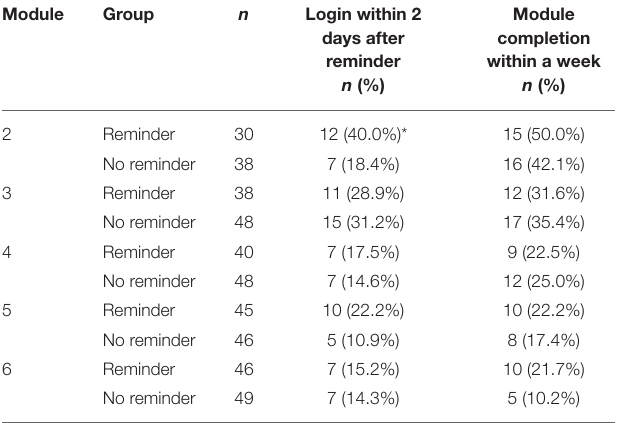
TABLE 3 | Between-group differences in weekly module completion and logins.